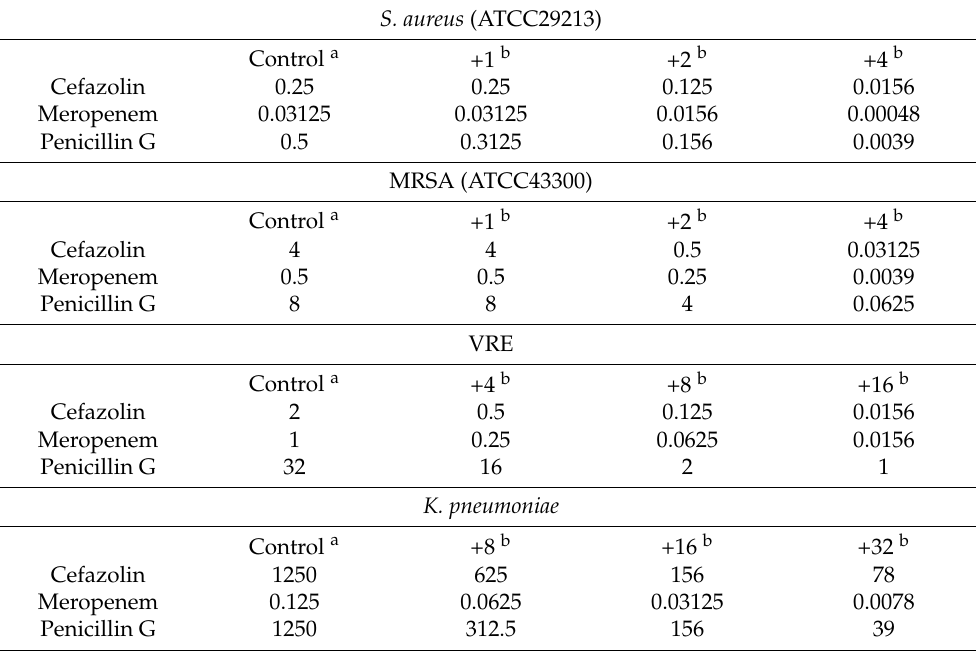
Table 2. Antibacterial activities (MICs, µ g/mL) of vancomycin derivative V b synergizing with β -lactam antibiotics against the resistant strains at a dose in the range of 1–32 µ